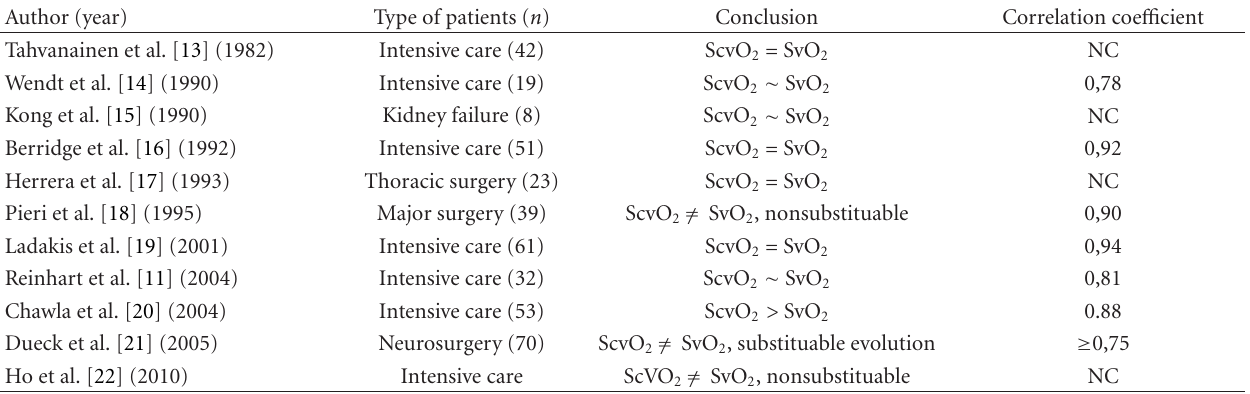
Table 1: Summary of the studies comparing SvO 2 and ScvO 2 in humans or in experimental